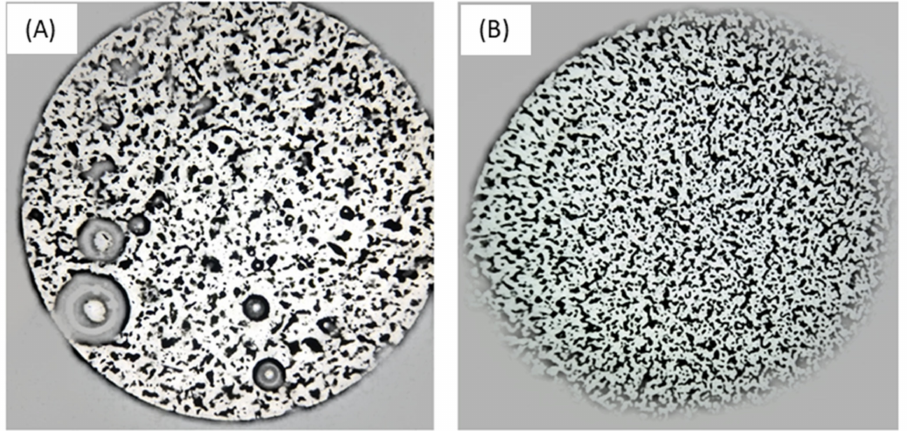
Figure 12. Micrographs of nanocompounds (100 × ) where GO dispersion in acetone was carried out at different times: ( A ) 30 min and ( B ) 60